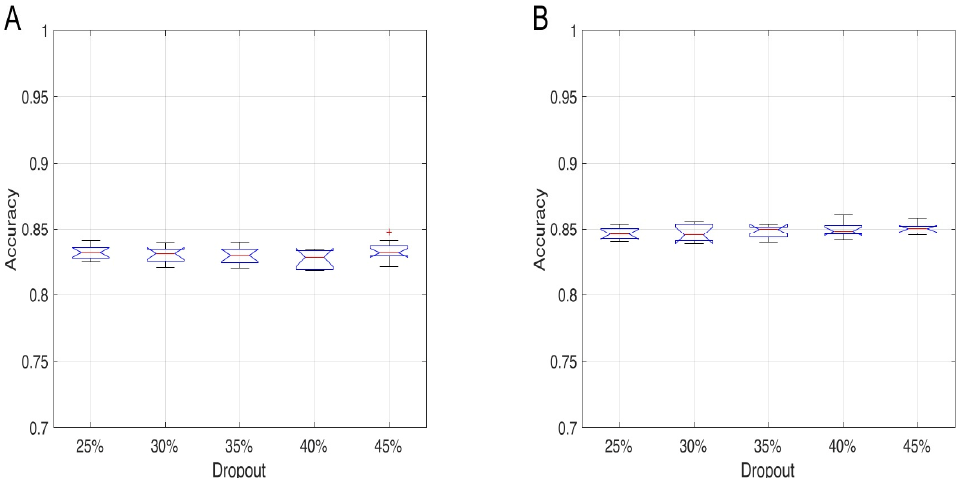
Figure 5. The overall test set accuracy distributions over 30 trained networks of two LSTM network architectures with different dropout levels. Panel ( A ): accuracy for a two LSTM layers network having 125 and 100 neurons in the first and second hidden layer, respectively. Panel ( B ): accuracy distributions for a one hidden bidirectional LSTM layer network with 125 neurons. Observations beyond the whisker length are marked as outliers and they are represented with “+” symbol.